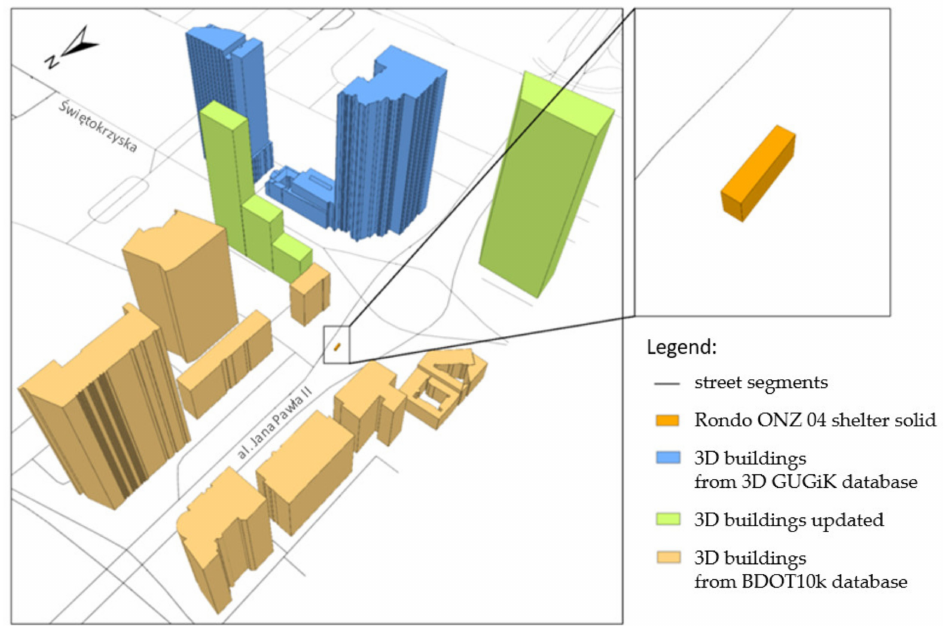
Figure 10. The result of the stage of data preparation for spatial analysis—3D layers for the surround- ings of the Rondo ONZ 04 tram stop.